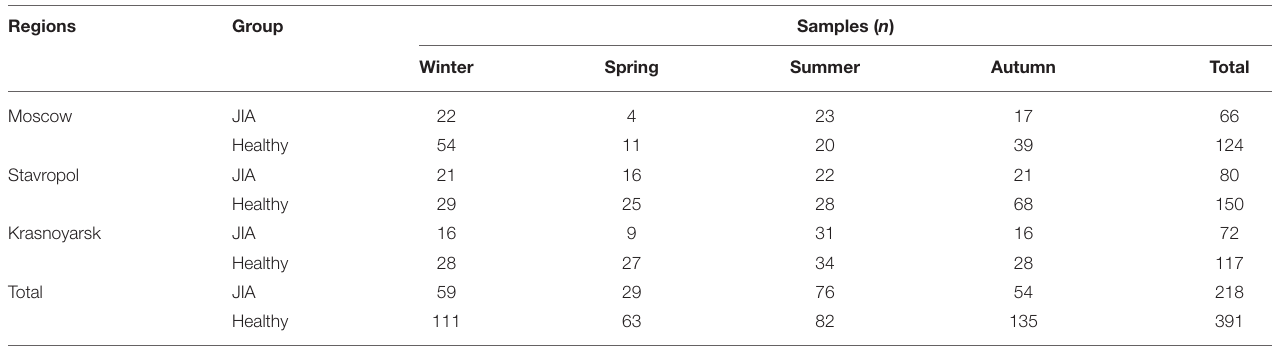
TABLE 2 | Number of blood samples used for the assessment of serum vitamin D levels in the JIA and control groups and for each season for each geographical region included in our study. Regions Group Samples ( n ) Winter Spring Summer Autumn Total